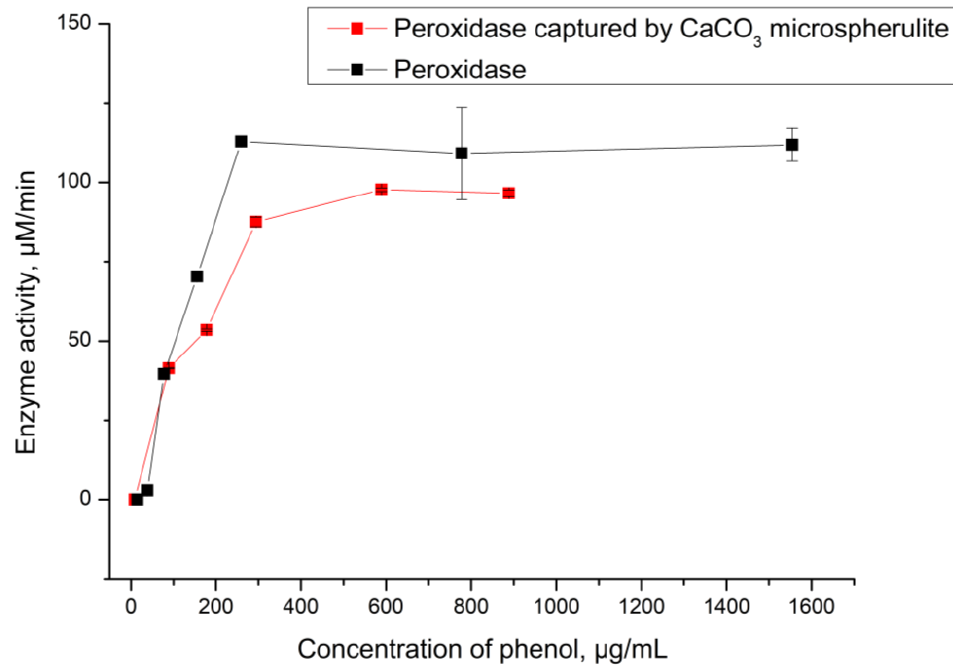
Figure 4. The activity of peroxidase captured by CaCO 3 depending on phenol concentration.